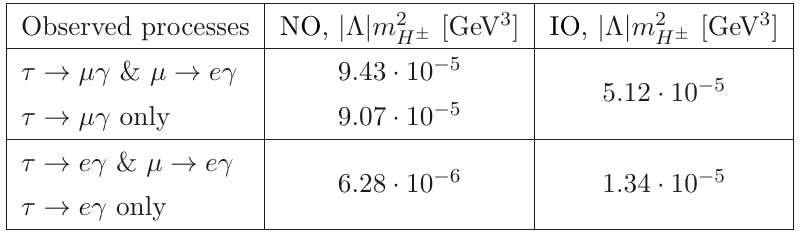
Upper bounds on the photon factor, of processes is observed in Belle-II and MEG-II. Each bound corresponds to a region in the ω 22 r plane in figure 7. −